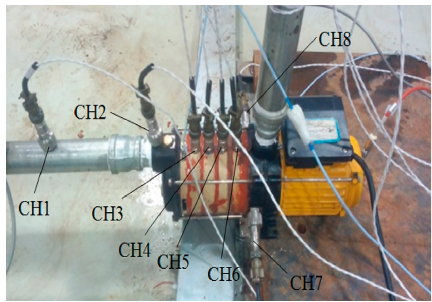
Figure 3: Installation of vibration sensors.